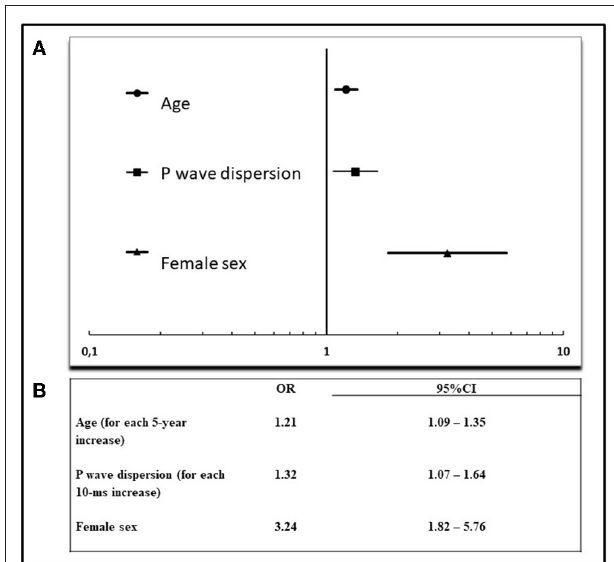
FIGURE 1 | Multivariate analysis of factors associated with severe ESUS. (A) Forest plot of significant factors associated with severe ESUS (according to Akaike’s information criterion), (B) results of multivariate analysis. OR, odds ratio; CI, confidence